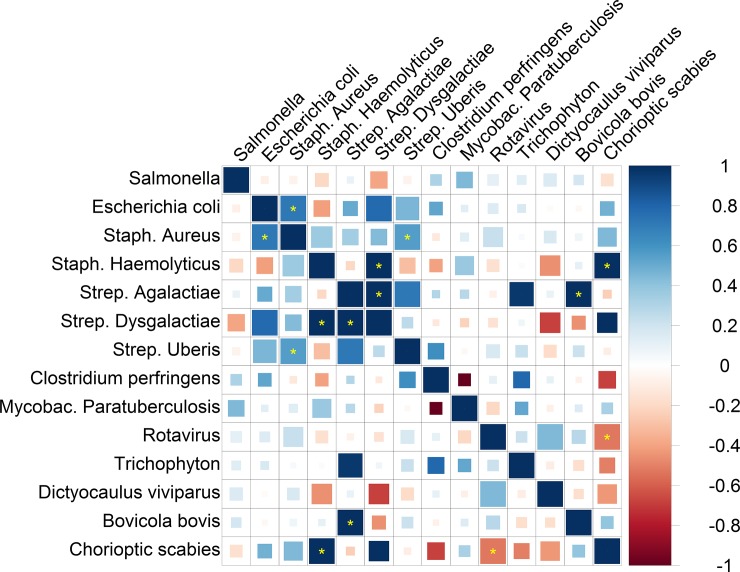
Genetic correlations among the 14 cow resistance traits analyzed by G-REML.Blue, positive genetic correlation; red, negative genetic correlation. Larger squares correspond to more significant P values. Genetic correlations that are different from zero at a false discovery rate (FDR) of 1% are shown as full-sized squares. Genetic correlations that are significantly different from zero after Bonferroni correction for the 105 tests in this analysis are marked with a yellow asterisk. We show results that do not pass multiple-testing correction as smaller squares. All genetic correlations in this report can be found in tabular form in S2 Table.